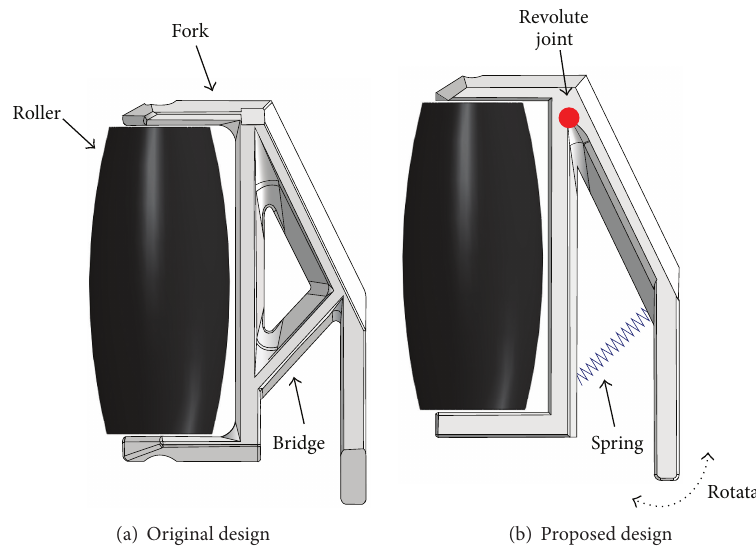
Figure 8: Original and a proposed design with a spring and a revolute